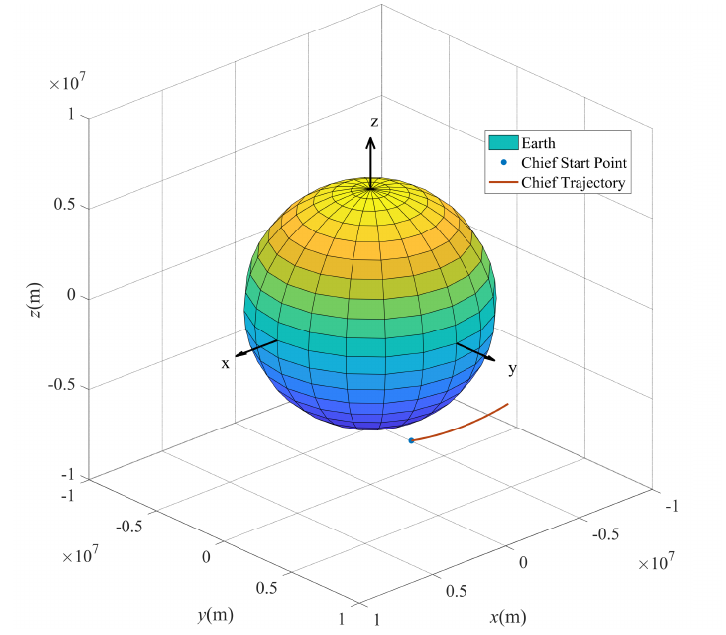
Figure 7. The nominal trajectory of the chief